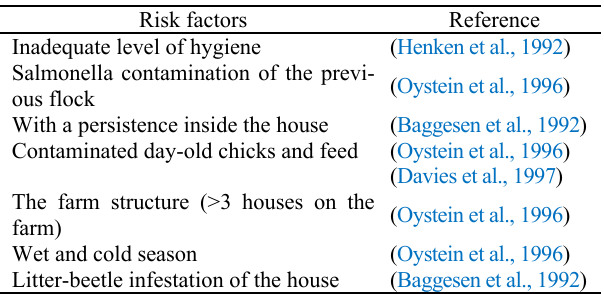
Factors responsible for Salmonella infection in a broiler- chicken